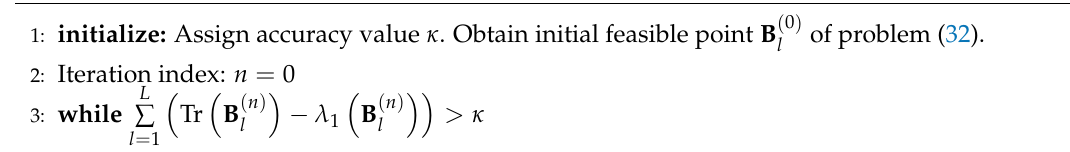
Algorithm 1 Proposed iterative algorithm with a penalty function for solving problem